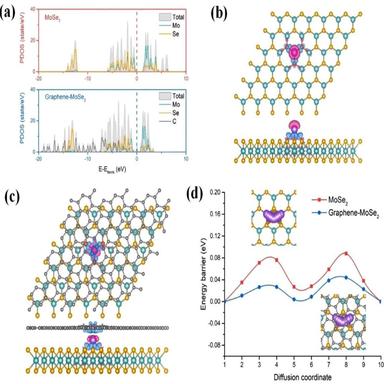
(a) PDOS of MoSe2 and graphene-MoSe2; (b) Differential charge density of Na+ adsorption on the MoSe2 surface; (c) Differential charge density of Na+ adsorption on the interface of graphene-MoSe2, respectively. Blue region represents electron accumulation and pink region for loss with 0.002 e A˚ −3 iso-surface value; (d) Energy curves of Na+ on the MoSe2 surface and interface of graphene-MoSe2.